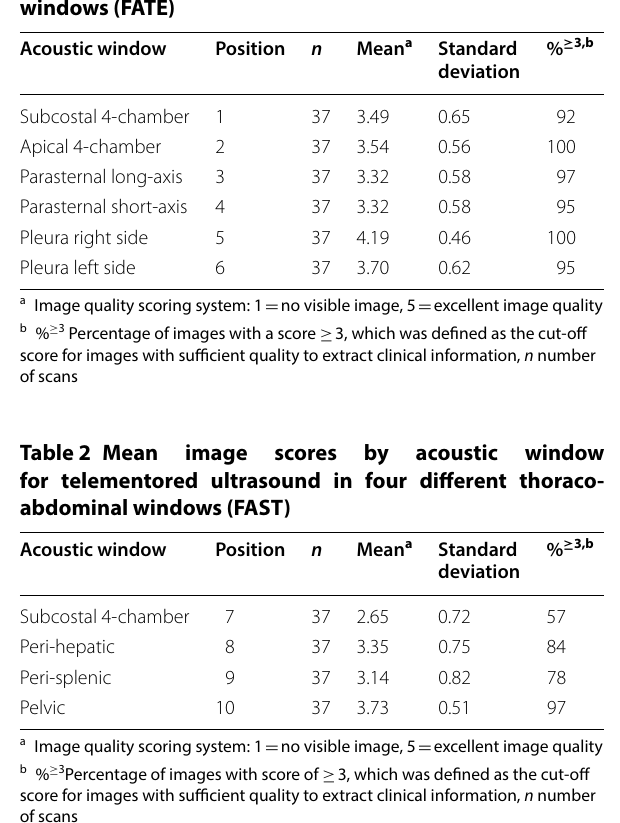
telementored 3 indicating ≥ 3 indicating ≥